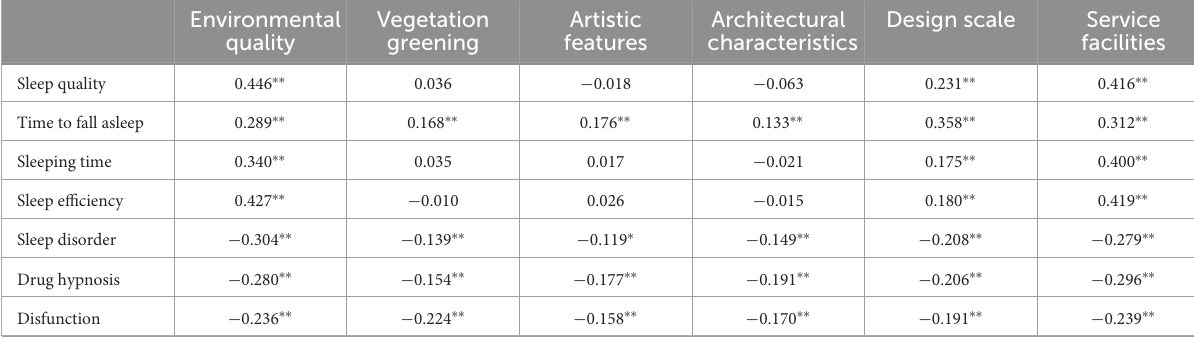
TABLE 5 Pearson correlation results of the physical environment and sleep.